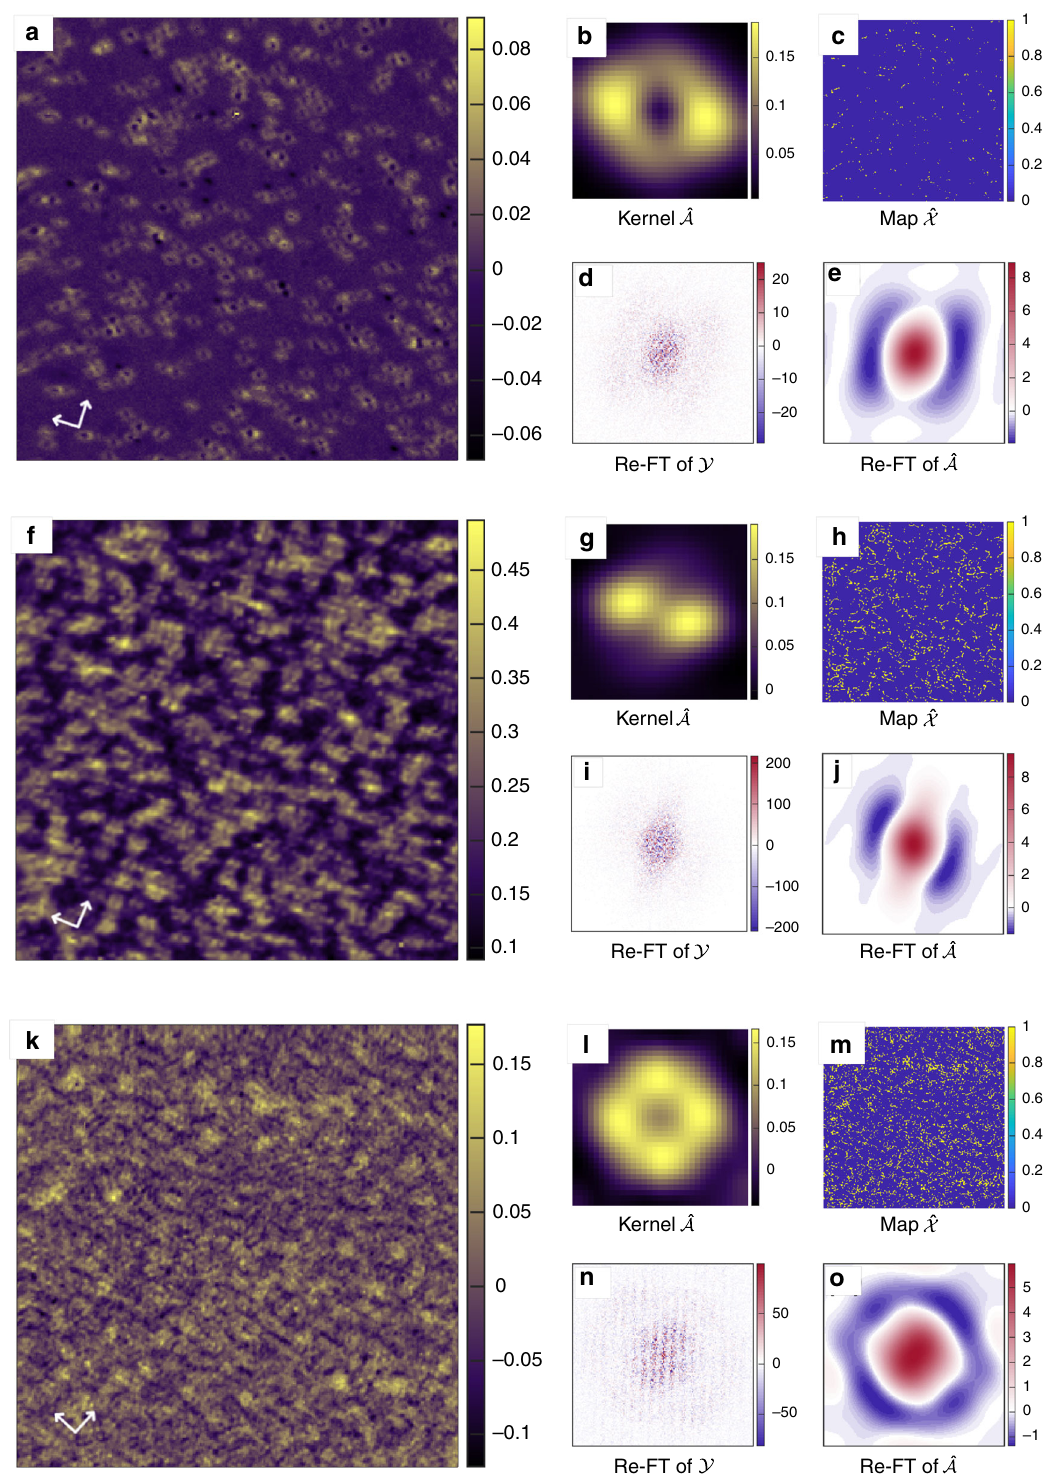
Fig. 5 Application to real data. SBD-STM recoveries with increasing density of defects. In the left column, we have conductance maps with Co defects in NaFe 1 − x Co x As of a high-quality ( T = 71 K, I = 59 pA, V set = − 100 mV, 114 × 114 nm 2 ), f x = 0.015 ( T = 6 K, I = − 200 pA, V set = − 20 mV, 50.4 × 50.4 nm 2 ), and k x = 0.02 ( T = 5.9 K, I = 200 pA, V set = − 50 mV, 250 × 250 nm 2 ) biased at energies of a 40 meV, f 5 meV, and k − 7 meV. The arrows indicate the principal directions of the lattice. In the right column, clockwise from the top left, we have the recovered kernel b , g , l , the recovered activation map c , h , m , the Re-FT of the kernel d , i , n , and the Re-FT of the conductance map e , j , o , for comparison. The recovered kernels have been given 2-fold rotational symmetry, and all activations have been set to 1 to make them more readily visible. The STM spectroscopy maps have been drift corrected as outlined in Supplementary Note 7. Color bars for real-space images are in units of nS, while color bars for Fourier images are in units of nS − 1